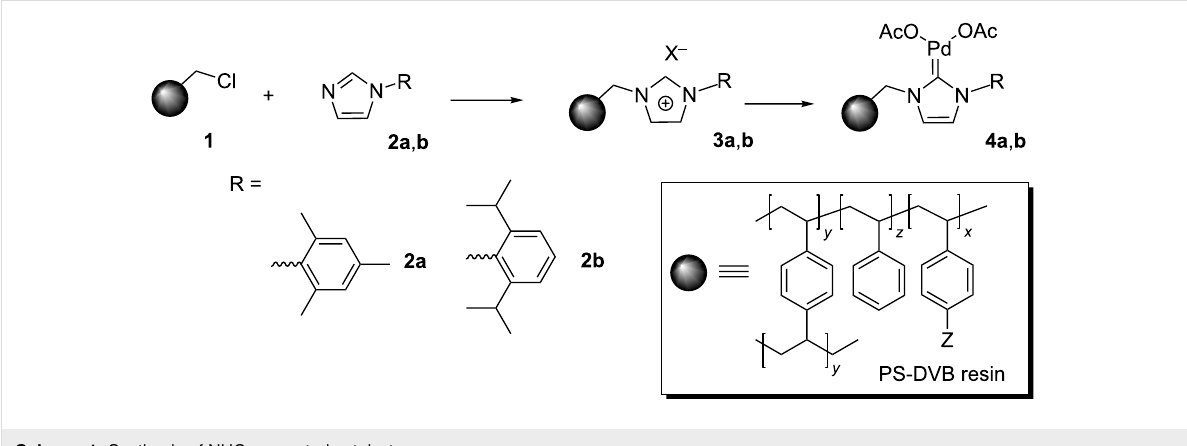
Scheme 1: Synthesis of NHC-supported catalysts.